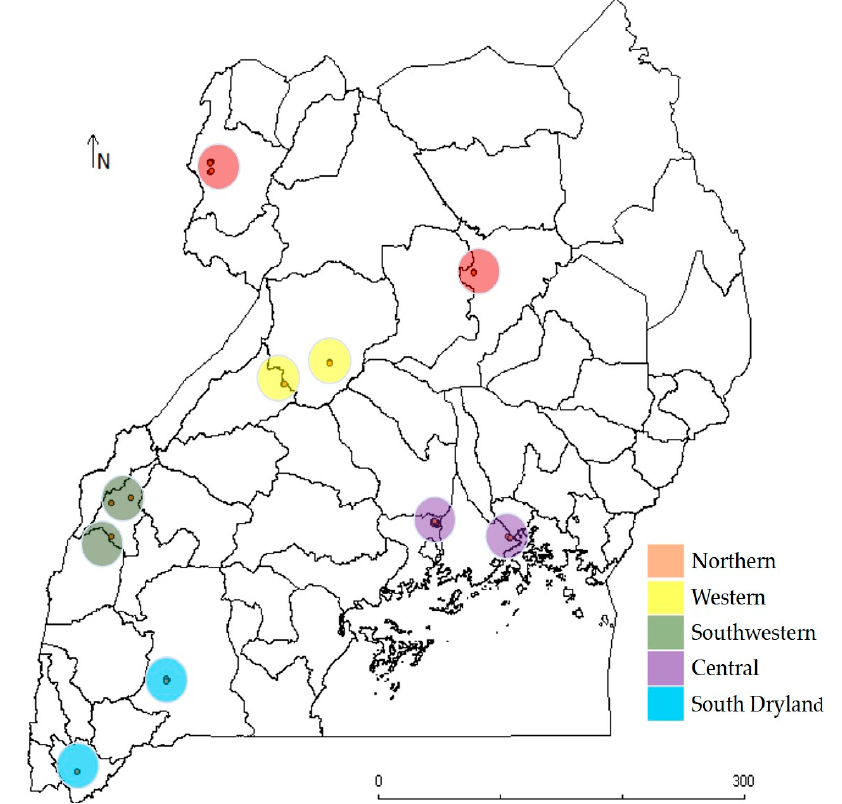
Figure 1. Map of Uganda showing Brachiaria ecotype collection sites in five regions (regions are coded in different colors). The map was generated using DIVA-GIS software.